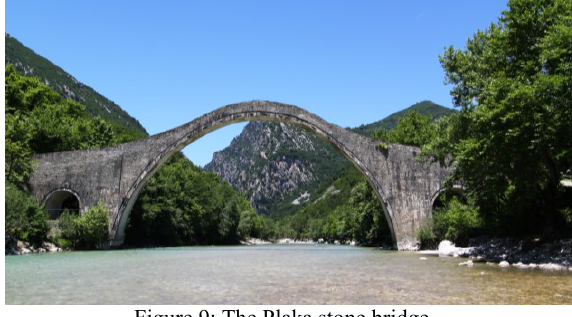
Figure 9: The Plaka stone bridge.